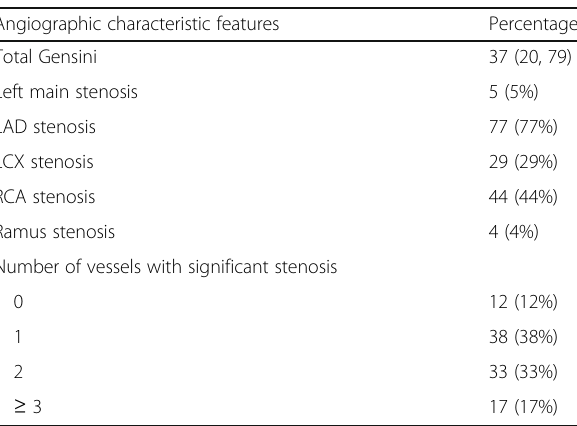
Table 3 Angiographic characteristic features of the studied patients